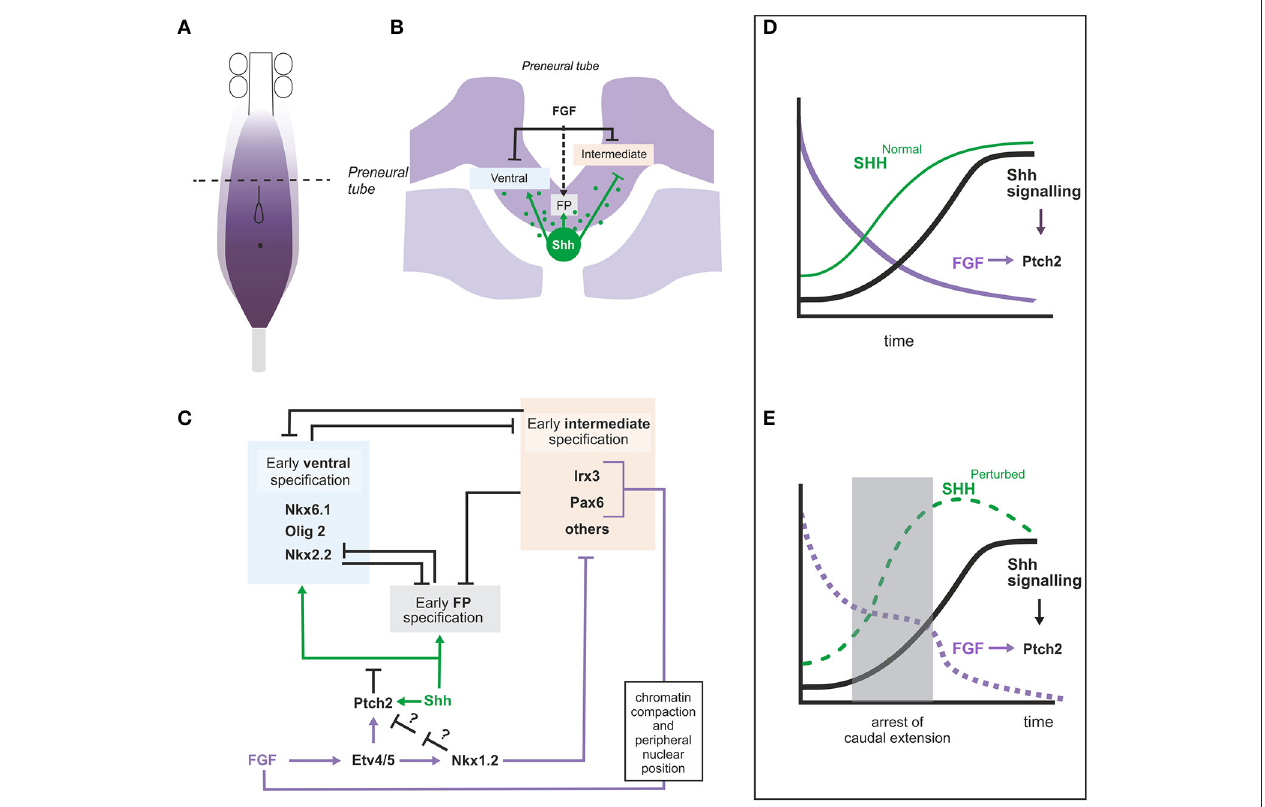
FIGURE 4 | Role of FGF signaling in the regionalization of the intermediate and ventral neural tube. (A) Diagram representing the caudal part of an embryo showing the region with active FGF signaling and the rostro-caudal level of the transverse section represented in (B) . (B) Transverse section at the level of the preneural tube showing the neural tissue and the underlying presomitic mesoderm and notochord. FGF8 (produced by neural and mesoderm tissues) and Shh (produced by notochord) are represented in purple and green respectively and their influence on intermediate, ventral and floorplate specification is shown. The dashed arrow indicates that FGF provides competence for floor plate specification. (C) Gene regulatory network relating FGF and Shh signaling in the pre-neural tube where the two signals coincide. Data from chick, mouse or both are included in this figure. (D,E) Graphs to illustrate the hypothetical role of the regulation of Ptch2 by FGF during the initial establishment of the Shh signaling levels. The graphs represent the changing levels of SHH in time at a particular position (within the dorsoventral and rostrocaudal axis). (D) In embryos continuously extending their caudal axis, the levels of FGF (purple) at a particular position would decrease constantly while the levels of SHH (green, SHH Normal ) would increase until they reach their maximum. The levels of Shh signaling thus also increase progressively. (E) In embryos where elongation is arrested for some time (shaded area), FGF levels would remain constant during the arrested period, while the levels of SHH (SHH Perturbed ) would accumulate more rapidly due to the decreased amount of tissue generated through which SHH could diffuse (or be transported). If Shh signaling was dependent exclusively on SHH levels, the level of the signaling would also increase to levels higher than normal and this may result in the irreversible activation of its targets. However, the ability of FGF to activate Ptch2 and thus downregulate the Shh pathway could serve to limit Shh signaling levels to normal values. FGF signaling levels (decaying in time) are shown in